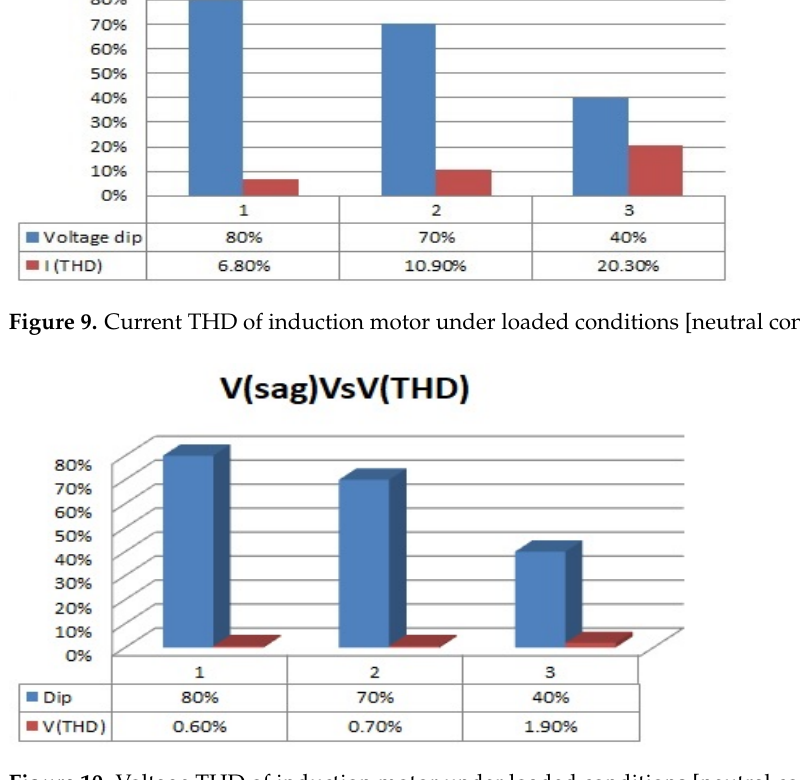
Figure 11. Voltage sag conditions in grid connected to induction motor under loaded conditions.